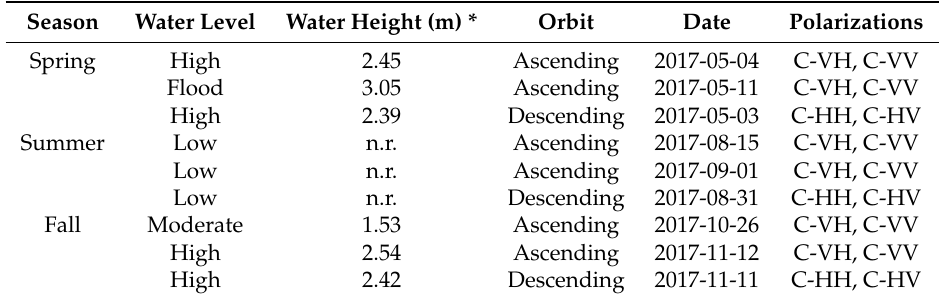
Table 4. Characteristics of the Sentinel-1 C-band imagery used in the study as a function of the season, water level, and